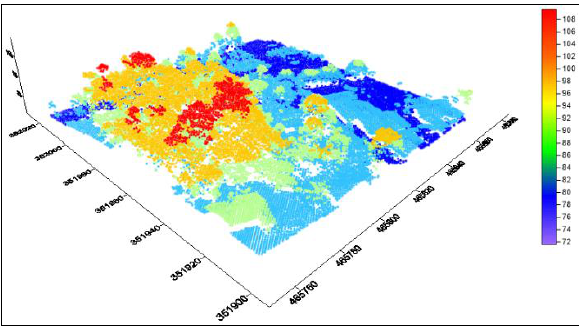
Figure 5. Raw airborne LiDAR data for mixed forest vegetation In order to perform validation or assessment for DTM generated, several Ground Control Points (GCPs) used for that purpose.